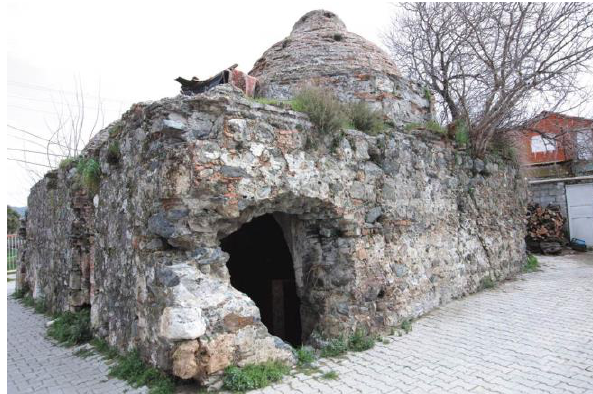
Figure 3 Studied building as viewed from the